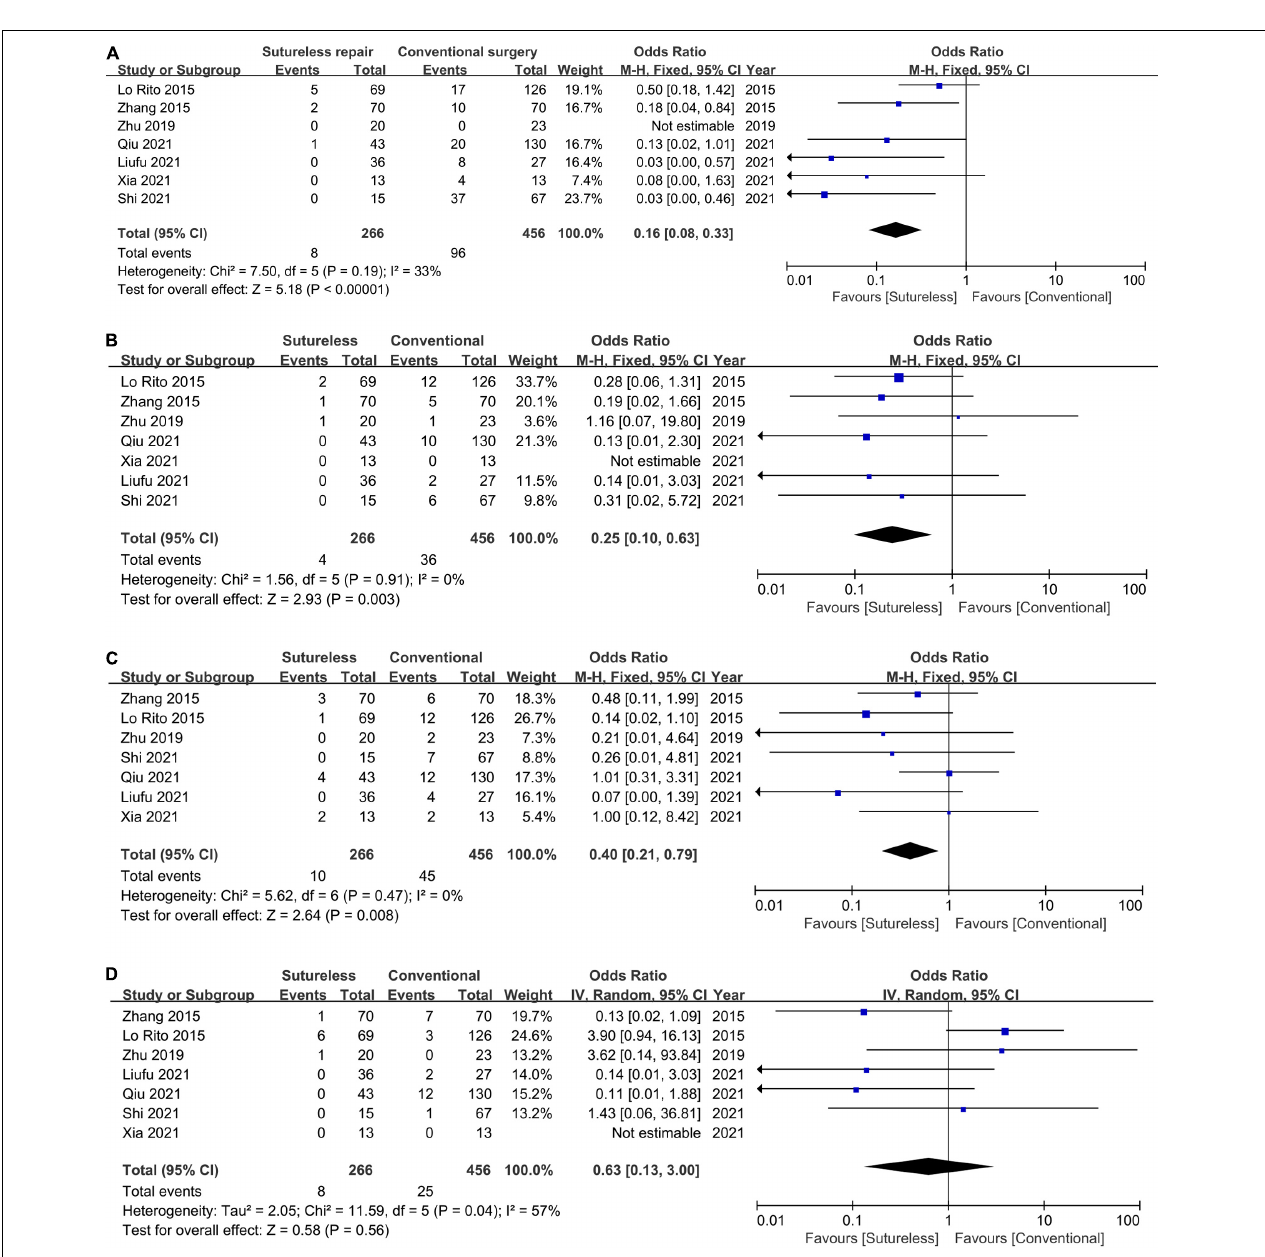
FIGURE 4 | Forest plot of odds ratio (OR) of post-operative PVO, early and late mortality, and reoperations due to PVO. (A) Forest plot of OR of postoperative PVO and pooled estimate OR of 0.16 in favor of the sutureless technique. (B) Forest plot of OR of reoperations due to PVO and pooled estimate OR of 0.25 in favor of the sutureless technique. (C) Forest plot of OR of early mortality and pooled estimate OR of 0.40 in favor of the sutureless technique. (D) Forest plot of OR of late mortality and no statistical difference was